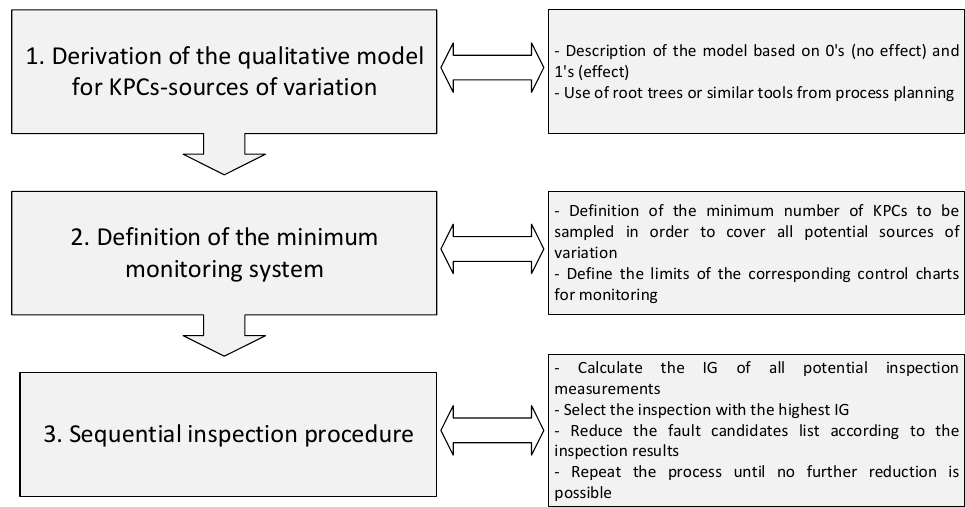
Figure 2. Methodology overview for fault detection based on sequential inspection.